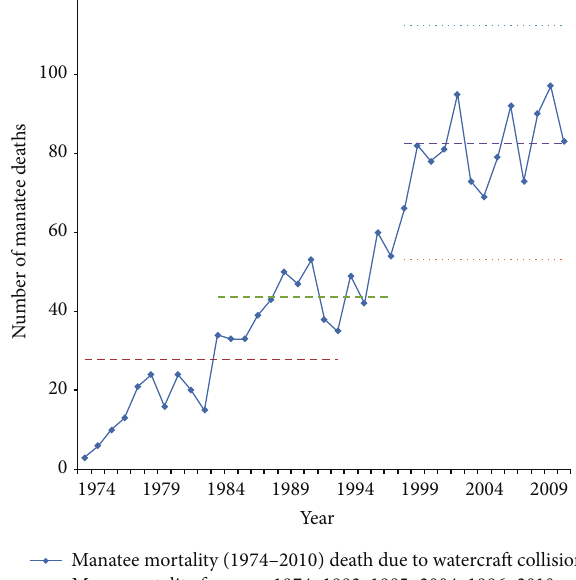
Figure 1: Deaths of Florida manatees due to watercraft collisions, showing changes in mean mortality (data from